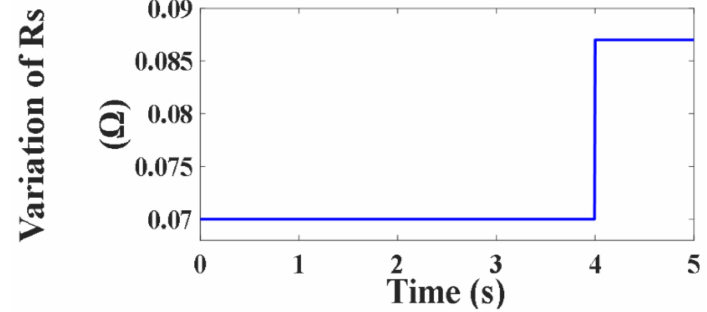
Figure 126. Variation of R s ( Ω ).